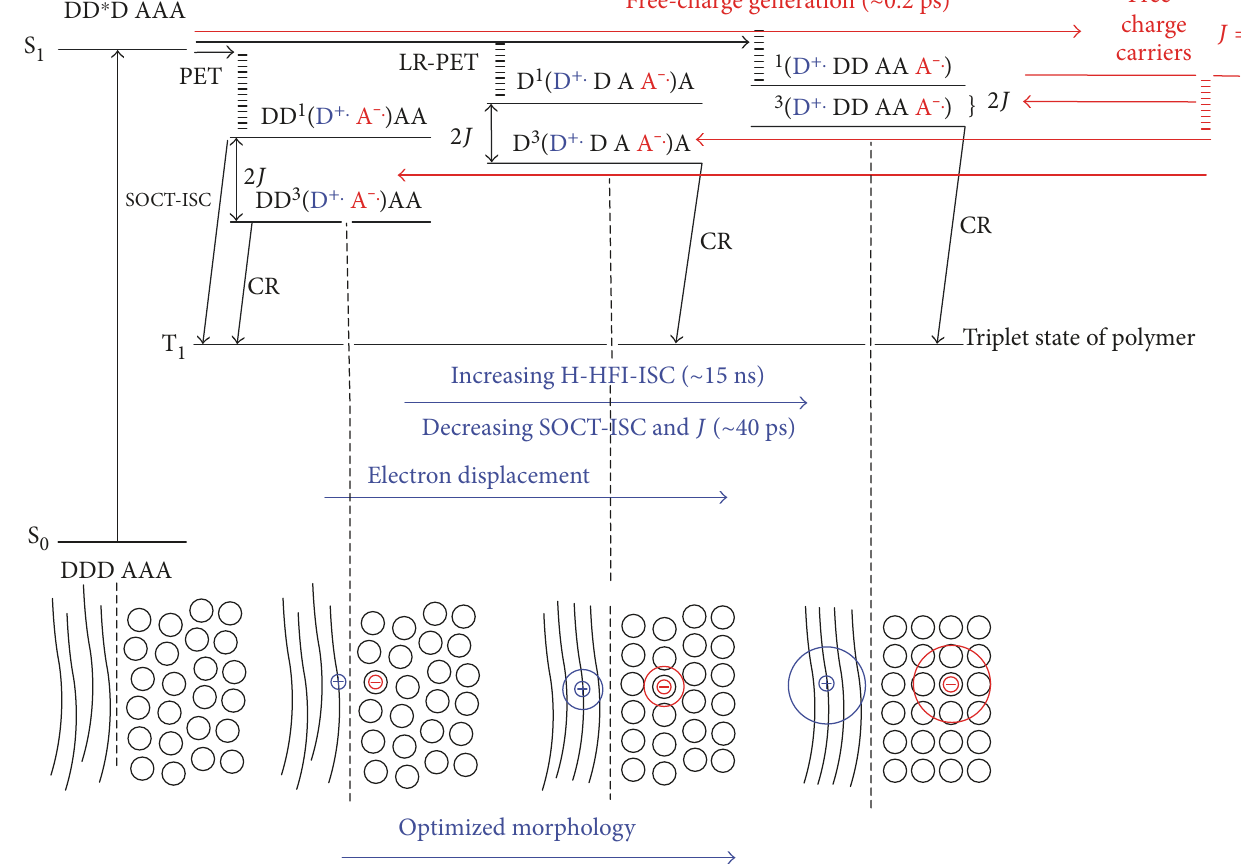
Figure 7: Representation of the e ff ect of morphology on charge recombination to the triplet state. Free-charge generation (FCG) occurs in 0.2ps. In a disordered morphology (COARSE), the charge transfer state is characterized by a larger J (exchange integral) and SOCT-ISC can play a more important role. In the well-ordered almost crystalline morphology, the charge transfer state has a smaller J . The contribution of the slower H-HFI interactions will become more important as J diminishes in size. The contribution of the faster SOCT-ISC becomes smaller upon going to the right side of the fi gure. For free-charge carriers (FCC), J equals zero. Charge recombination from 3 CT to T is spin allowed. Note that the e ff ect of optimized morphology (increased organization) on polaron 1 energetics is neglected. More organization can lead to lowering of the energies of the positive polaron, the negative polaron, and the free-charge carriers (FCC) (relative to the coulomb bound charge transfer state) because of delocalization and entropy e ff ects. In principle, photo-induced electron transfer (PET) can also populate the CT states over long ranges (LR) for the optimized morphology.